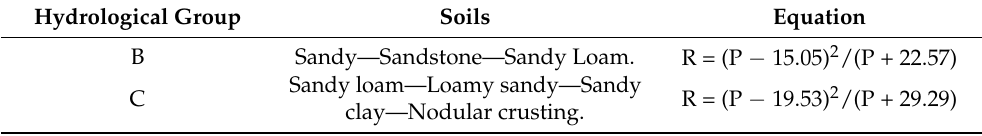
Table 1. Hydrological groups covering the meteorological station in the zone of study [50]. Hydrological Group Soils Equation B Sandy—Sandstone—Sandy Loam. R = (P − 15.05) 2 /(P + 22.57) Sandy loam—Loamy sandy—Sandy C R = (P − 19.53) 2 /(P + clay—Nodular crusting.